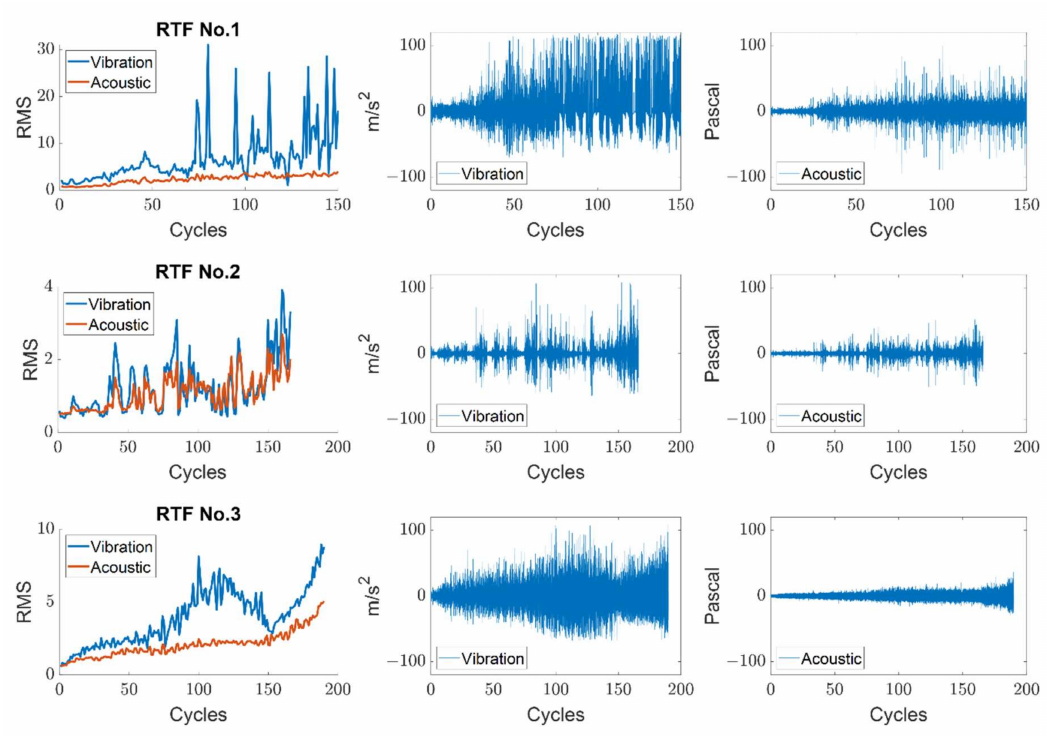
Figure 7. Comparison of RMS and raw vibration and acoustic signals for three run-to-fail datasets. The prognosis performance for each sensor was calculated using the time window metric. The window size ( N t ) was fixed at 50 cycles and initial prediction started from 50 cycles ( M ). Then, the performance metrics such as the accuracy ( NMSD ) and uncertainty ( EI ) were calculated for every cycle until failure. For example, Figure 8a,b shows the prediction results by the vibration sensor for RTF No.1 data when M is 50 and 95 cycles, respectively. Figure 8d,e are the prediction results by the acoustic sensor. The black and red dots denote the measurements until the current cycle and future cycles in the time window, respectively. The red dashed line and red shaded areas are the predicted median and 90% C.I. in the future. Figure 8c,f are the NMSD and EI calculated at each cycle from 50 to 95 cycles. The calculated NMSD and EI results obtained in Figure 8a,d are the first values for the vibration and acoustic sensors in Figure 8c,f, respectively. In order to compare the prognostic performance of the sensors, the values of NMSD and EI were averaged over all subsequent cycles, respectively. In the case of the acoustic sensor, the results were also obtained for different data intervals to examine its effect accordingly. The results are